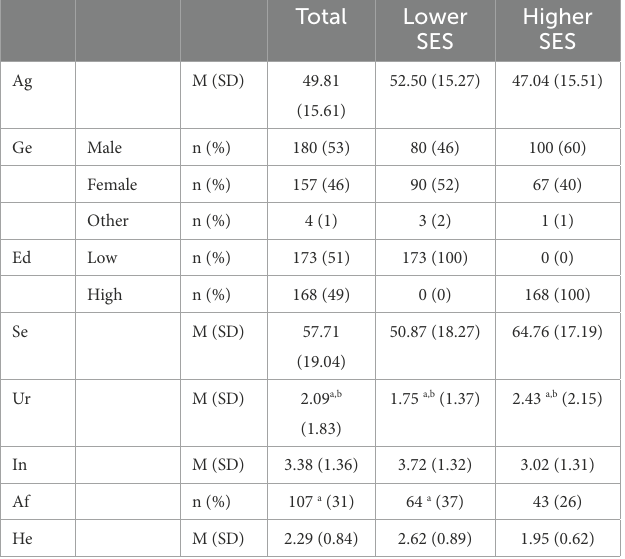
TABLE 1 Factors and covariates, describing eight background